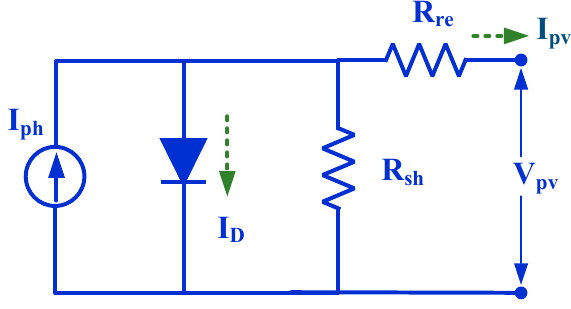
Figure 1. The equivalent circuit of photovoltaic (PV) cell.